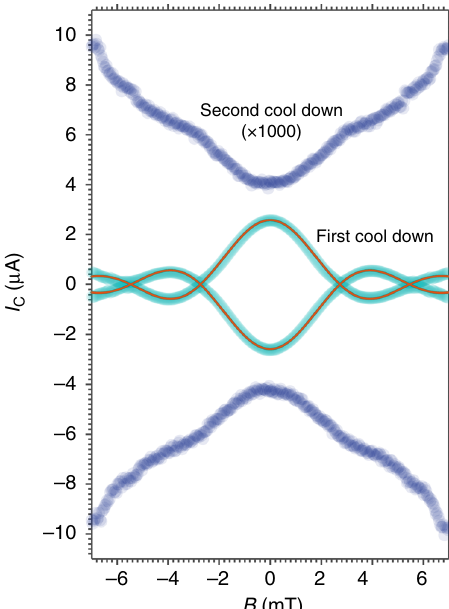
Fig. 2 Magnetic fi eld pattern of a typical junction before and after the thermal cycle. Critical current I C dependence on the externally applied magnetic fi eld B for the junction of Fig. 1c at 20 mK, before (cyan) and after (blue) the thermal cycle. At the fi rst cool down the I C (B) dependence shows a conventional Fraunhofer dependence fi tted with the expression I B ð Þ ¼ I ð Þj sin πϕ = ϕ ð Þ = πϕ = ϕ ð Þj (red line) where I C (0) is the critical C C 0 0 0 current at zero fi eld, ϕ 0 is the fl ux quantum, and ϕ = BA eff is the fl ux through the junction, being A eff the effective area. After the thermal cycle (blue points), the critical current is dramatically reduced (the data points are multiplied by a factor 1000 for clarity), and a dip at B = 0